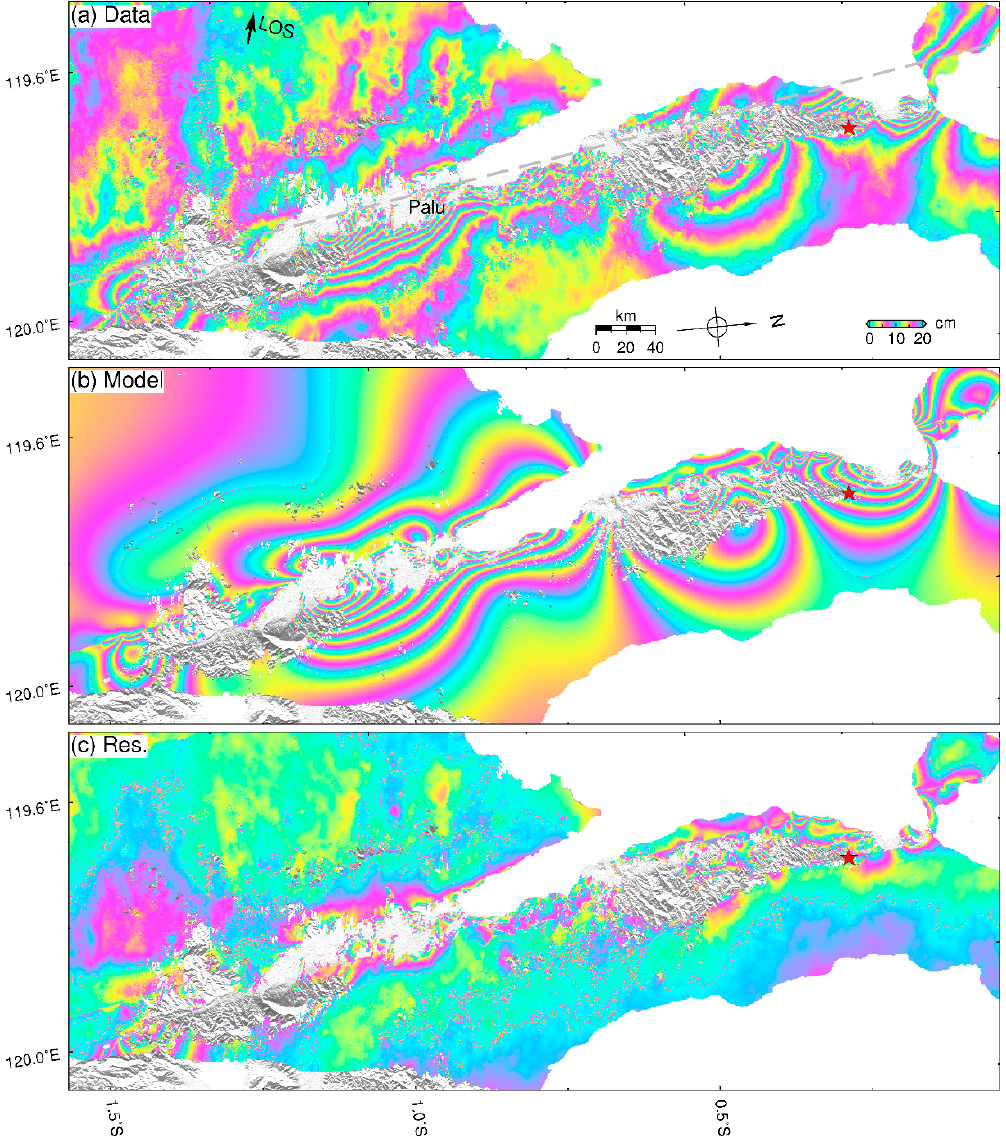
Figure 2. The observed ( a ), modeled ( b ), and residual ( c ) coseismic LOS displacement of the 2018 Palu earthquake based on the joint inversion. The gray dashed line in (a) shows the fault trace used in the joint inversion. All the results are rewrapped in the range of 0 to 20 cm.